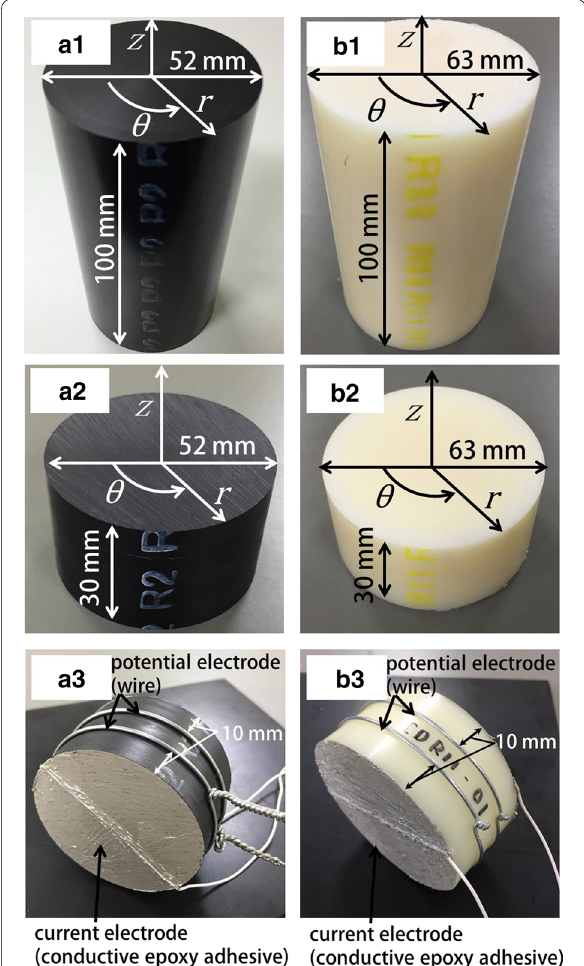
Fig. 10 Photographs of set-up for measurement of plastic samples overlaid with the dimensions r , θ , and z defining the coordinate axis. Top row: cylindrical plastic samples a1 MC501CD R2 (Mitsubishi Chemical Advanced Materials, Tokyo, Japan; 52 mm diameter, 100 mm length) and b1 MC500AS R11 (Mitsubishi Chemical Advanced Materials, Tokyo, Japan; 63 mm diameter, 100 mm length). Middle row: thin-disk plastic samples (52 mm diameter, 30 length) of a2 MC501CD R2 and b2 MC500AS R11. Bottom row: arrangement of wire potential electrodes around the thin-disk samples’ side surface and conductive epoxy-adhesive current electrodes attached to their ends, a3 MC501CD R2 and b3 MC500AS